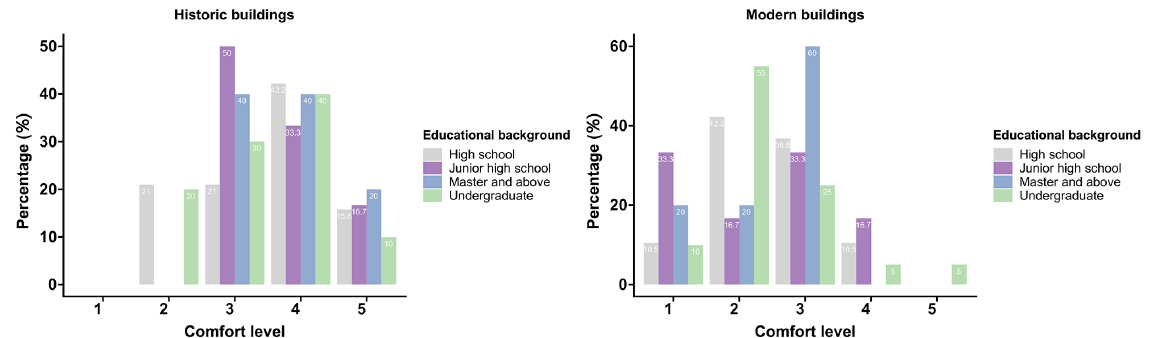
Figure 7. Percentage of evaluation levels with di ff erences in educational background.